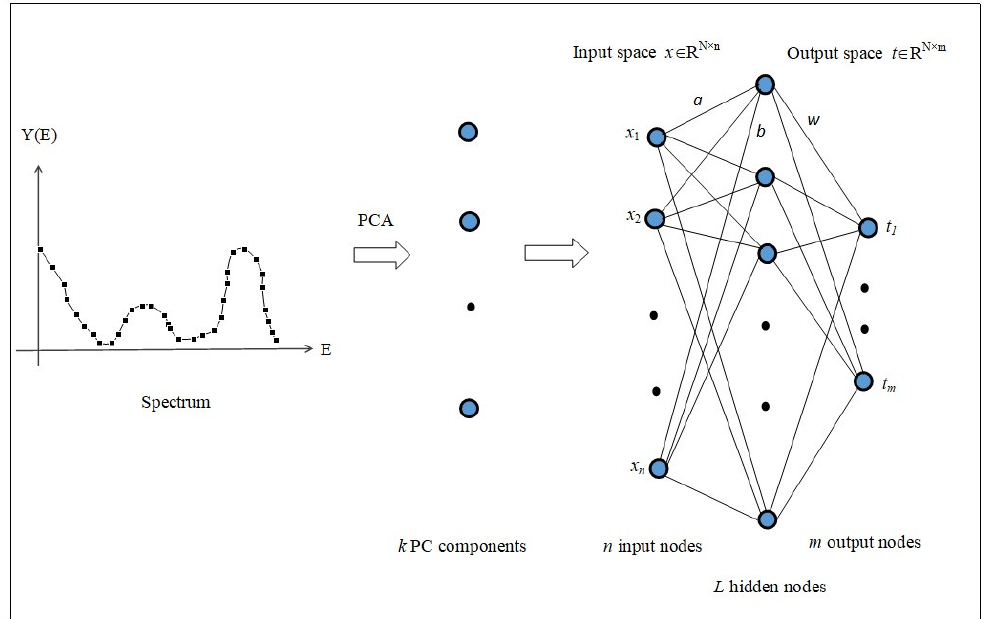
Figure 2. The extreme learning machine (ELM) architecture diagram for the current RBS data analysis problem.